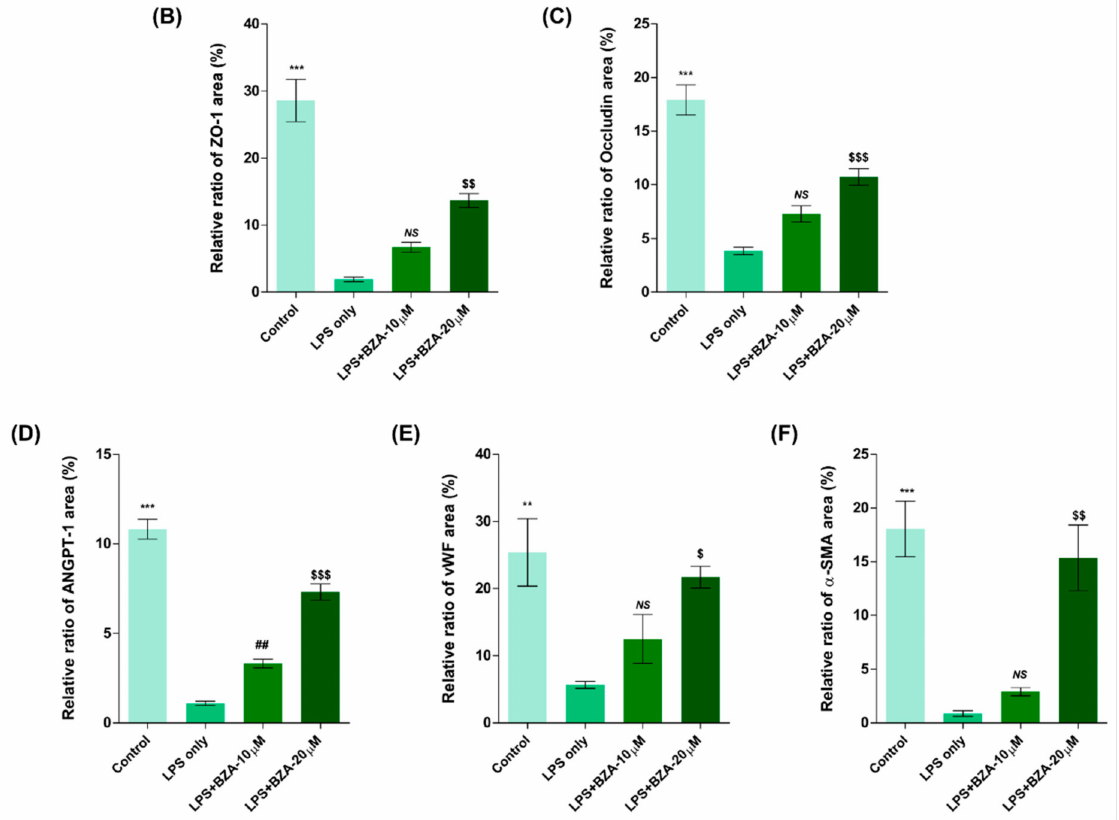
Figure 3. BZA increases angiogenesis and decreases BSCB destruction in vitro. ( A ) Representative immunofluorescent images (scale bar = 20 µ m) of tight junction proteins such as ZO-1 and occludin and angiogenesis markers including ANGPT-1, vWF, and α -SMA examined in hCMEC/D3 cells. Quantitative fluorescence intensity for ( B ) ZO-1, ( C ) occludin, ( D ) ANGPT-1, ( E ) vWF, and ( F ) α -SMA. Data represent mean ± SEM ( n = 3 ( A , C ), n = 4 ( D ), n = 6 ( F ); performed in triplicate). ** p < 0.01, *** p < 0.001 (LPS-treated vs. control, DMSO), ## p < 0.01 (LPS-treated vs. LPS + BZA 10 µ M), $ p < 0.05, $$ p < 0.01, $$$ p < 0.001 (LPS-treated vs. LPS + BZA 20 µ M) , NS = Not significant, one-way ANOVA followed by the Bonferroni